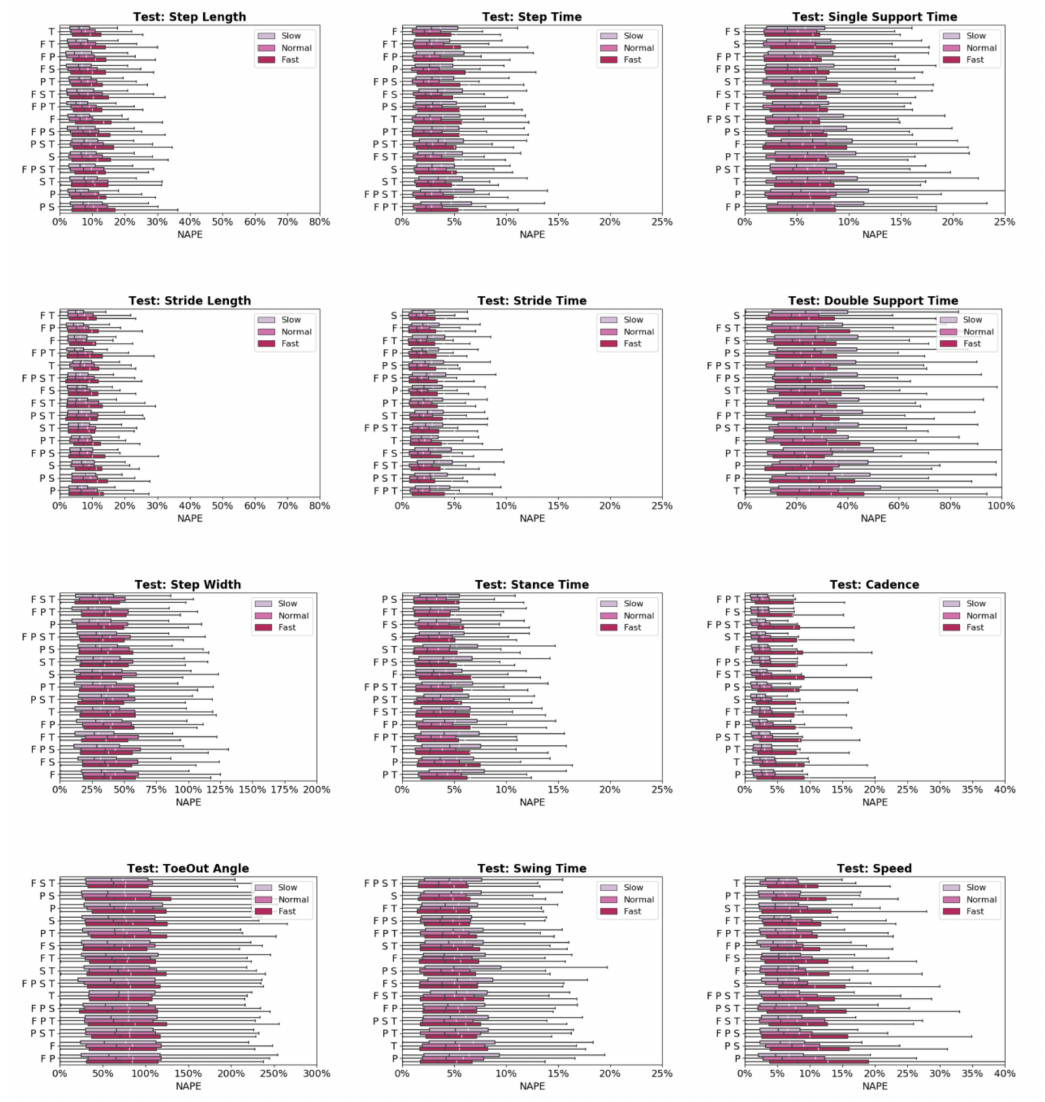
Figure 5. Normalized absolute percentage error (NAPE) of neural network predictions for all gait parameters and various sensors configurations grouped by gait pace (slow, self-selected, fast) in the test set. For each gait parameter, sensor configurations are listed in order of increasing